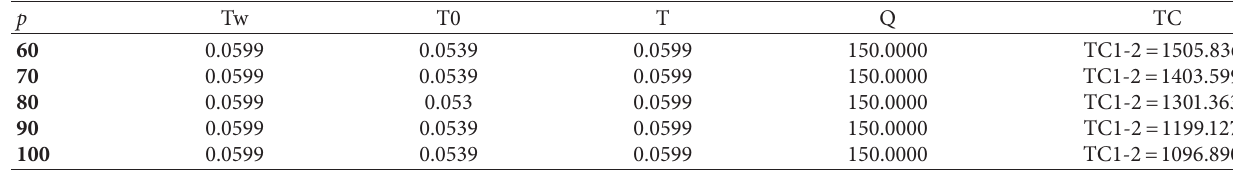
Table 3: The obtained solutions under different values of p.